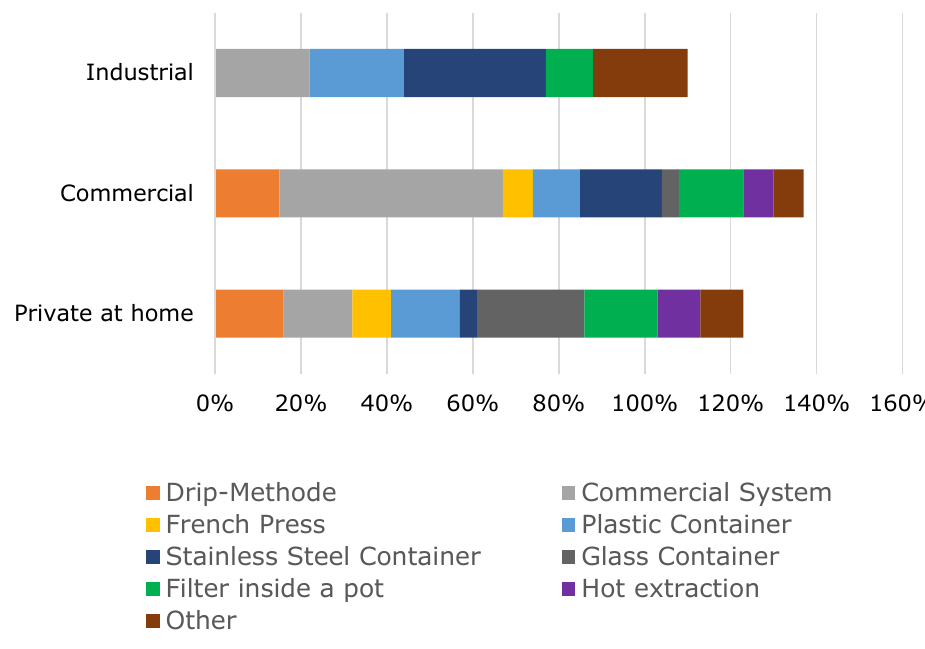
Figure 1. Extraction method of cold brew coffee (note: percentage values above 100 to be explained by multiple answers).